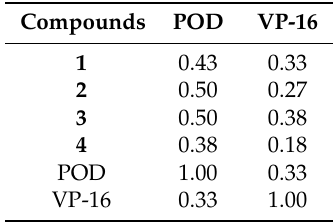
Table 4. Structural similarity coefficients (Tc). The compounds were compared against the controls, according to calculated